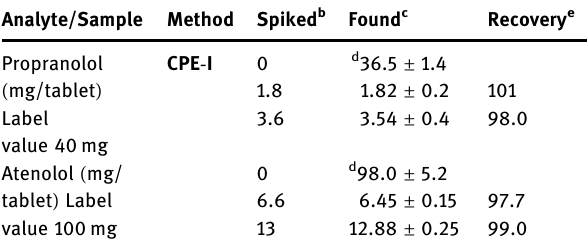
Analyte/Sample Method Spiked b Found c Recovery